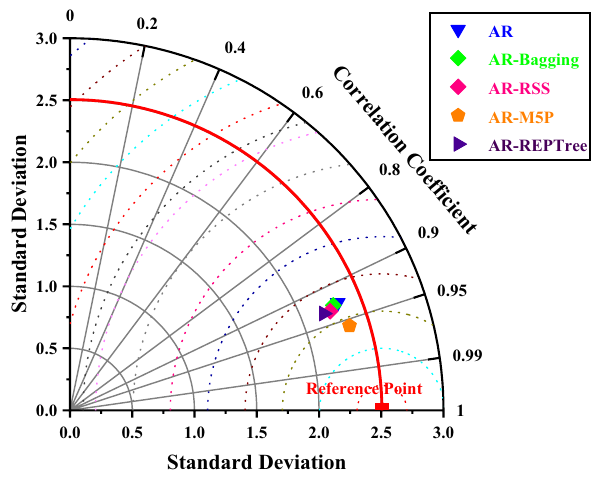
Fig. 8 Taylor diagrams of AR, AR-bagging, AR-RSS, AR-M5P, and AR-REPTree during testing span at Faisalabad station